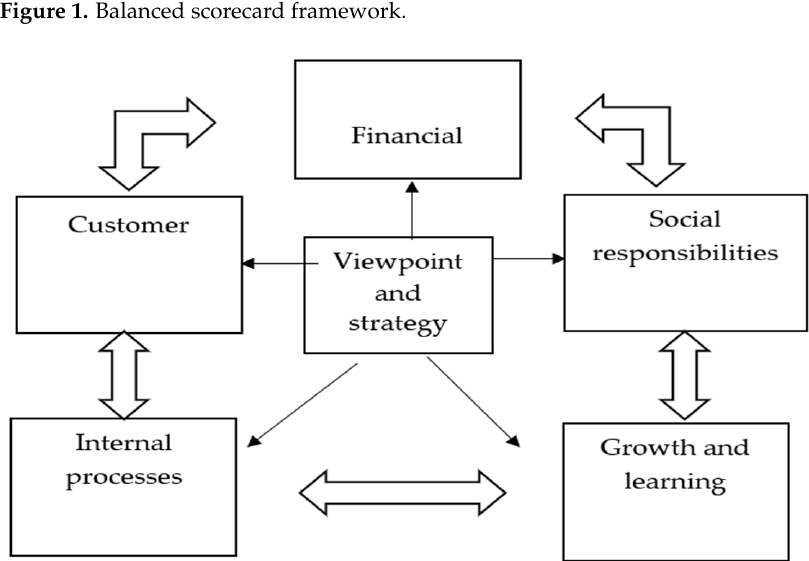
Figure 2. Five domains of the balanced scorecard in the municipality .